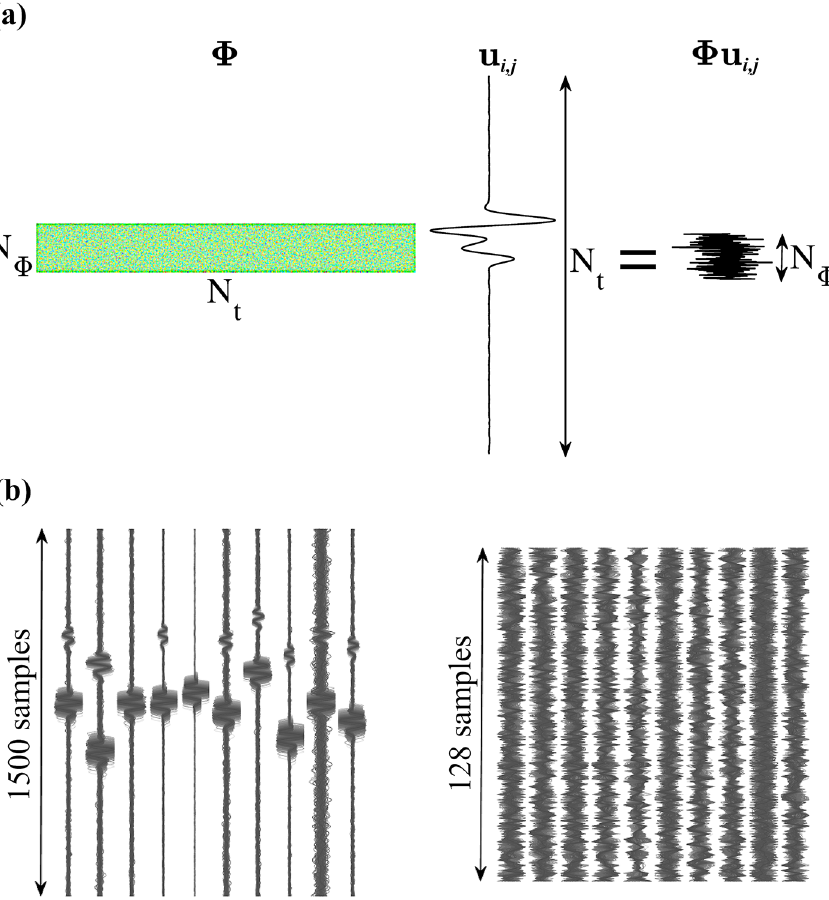
Figure 1. Examples of data compression. ( a ) A seismogram u i , j is compressed from R N t × 1 to R N (cid:31) × 1 using an encoding matrix (cid:31) constructed with independent and identically distributed samples drawn from a Gaussian distribution with zero mean and standard deviation of 1/ N t . ( b ) Probabilistic pattern of arrivals (left) and a compressed domain representation of it (right) for a source with fixed location and moment tensor. Arrivals were modeled with normal distributions of compressional and shear velocities and contaminated with band- limited Gaussian noise. Variations in SNR are the result of local conditions and the source radiation